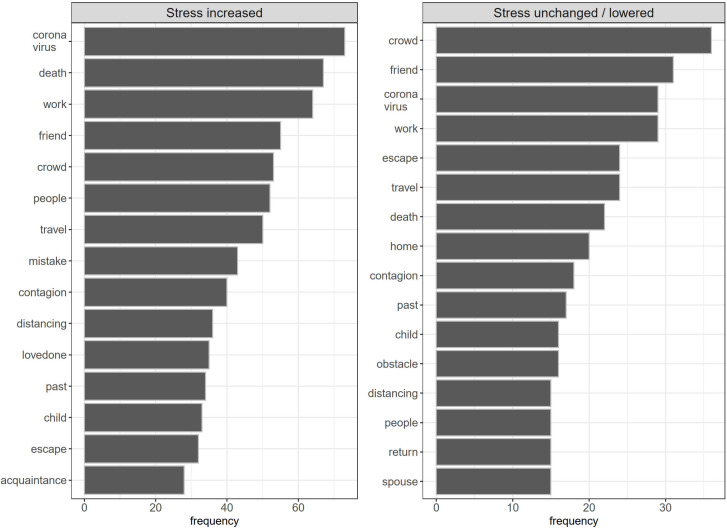
The appearance frequency of different words in dream reports according to the experience of COVID-19–related stress (left panel: stress increased; right panel: stress unchanged/lowered).